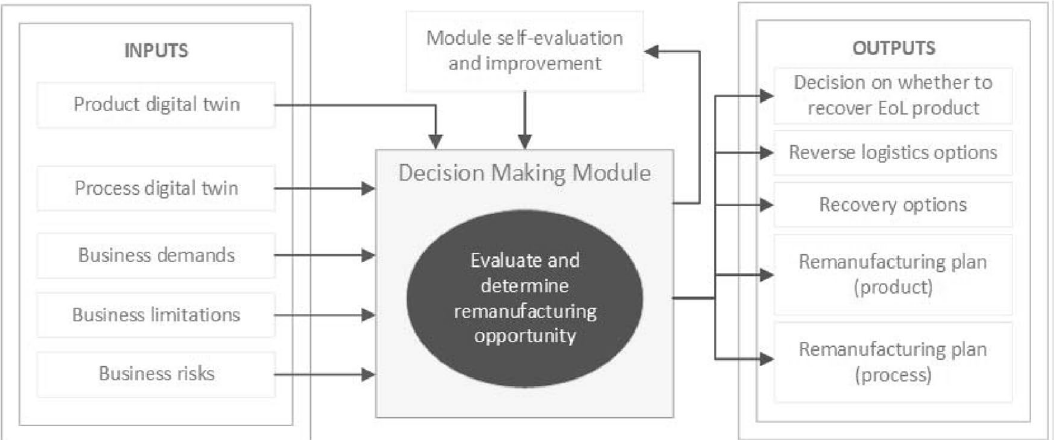
Figure 1. Inputs to and outputs from the decision-making